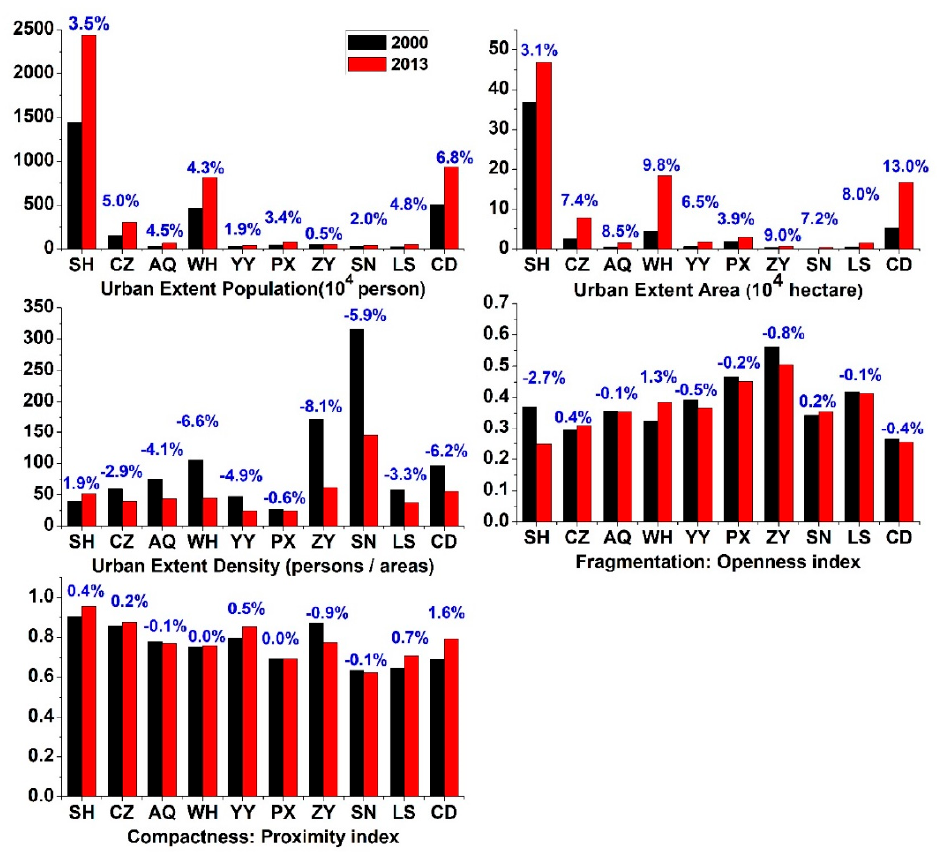
Figure 9. Similar to Figure 8, but for the changes in the five urban form metrics.